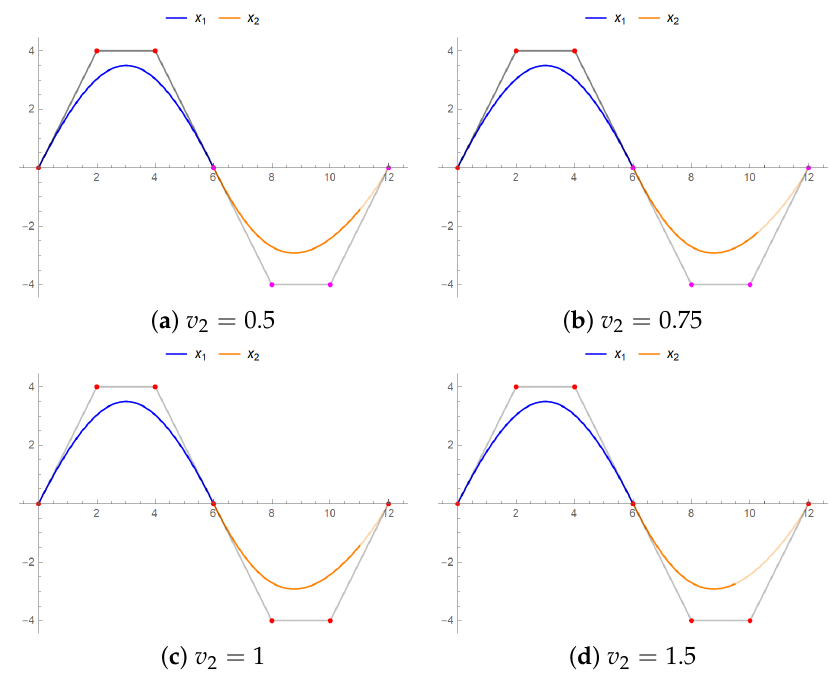
Figure 9. C 1 continuity of two cubic fractional Bézier